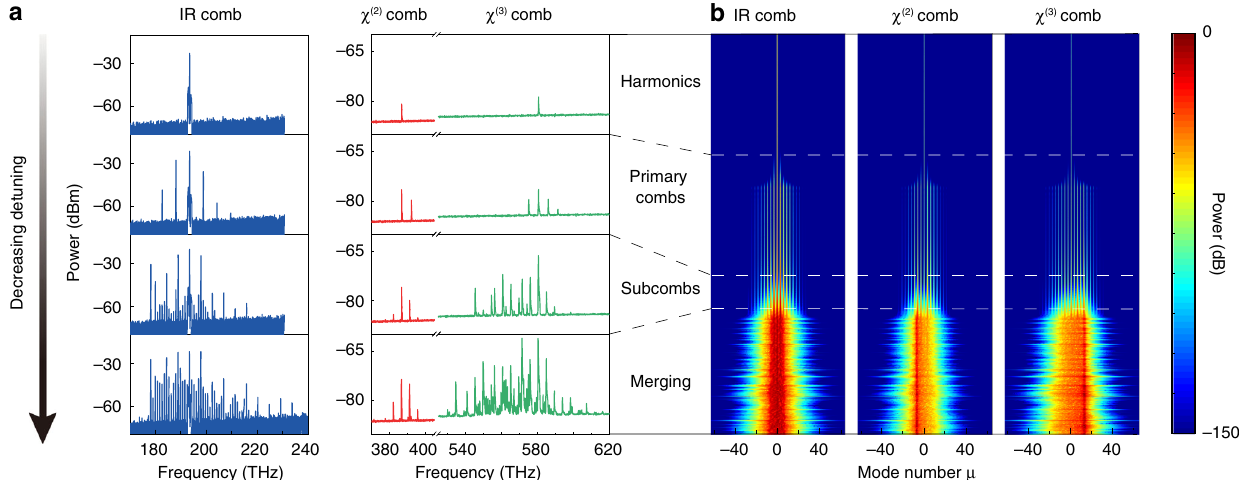
Fig. 3 Formation process of microcombs. a Four representative optical spectra of microcombs. The amplitude of cavity-laser detuning is gradually decreased from top to bottom. The second and third harmonic generation is observed fi rst, followed by the primary combs in all three frequency bands. Subcombs are then generated and they slowly merge with the decrease of detuning. b Simulated microcomb formation process. Pump detuning is scanned from shorter to longer wavelength, and the spectrum evolution of microcomb is presented. The intracavity power for three bands is normalized to the largest value of their own experiment, a micro fi ber and a nano fi ber are simultaneously is used to collect the comb light through chaos-assisted coupling. coupled to the deformed cavity (Fig. 4a). The diameter of the micro fi ber is set to 1.5 μ m to achieve phase-matched coupling with the whispering-gallery mode at 1550 nm. The 0.5- μ m- diameter nano fi ber has effective refractive index close to 1, and it